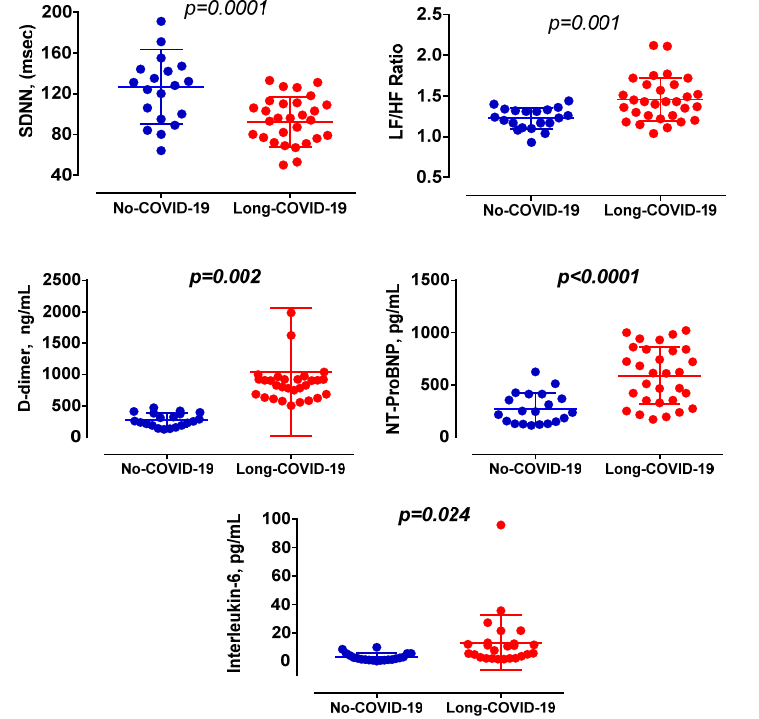
Figure 1. Main relationship of HRV (SDNN, LF/HF ratio), D-Dimer, NT-ProBNP, and IL-6 in No- COVID-19 compared to Long-COVID-19 patients.